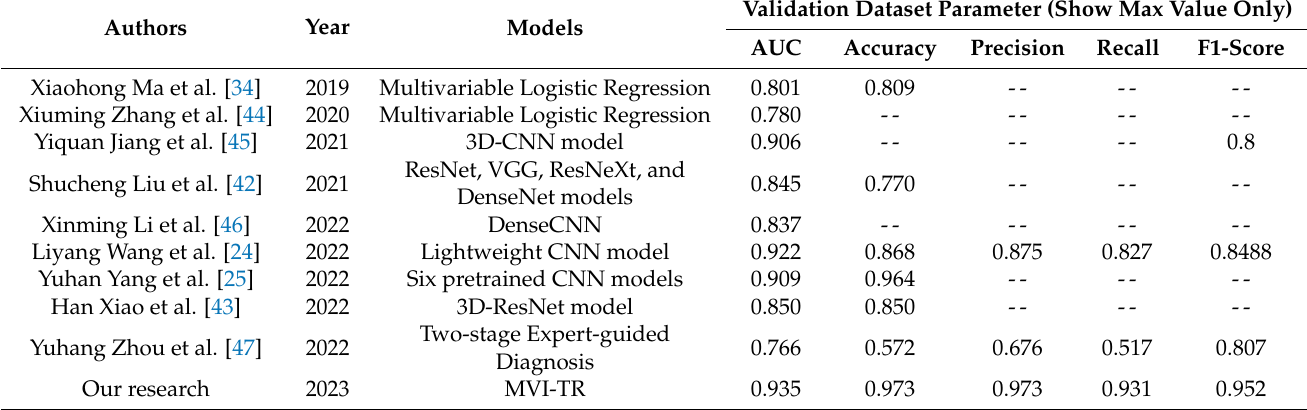
Table 4. The performance of MVI-TR compared with previous deep learning work. Validation Dataset Parameter (Show Max Value Models